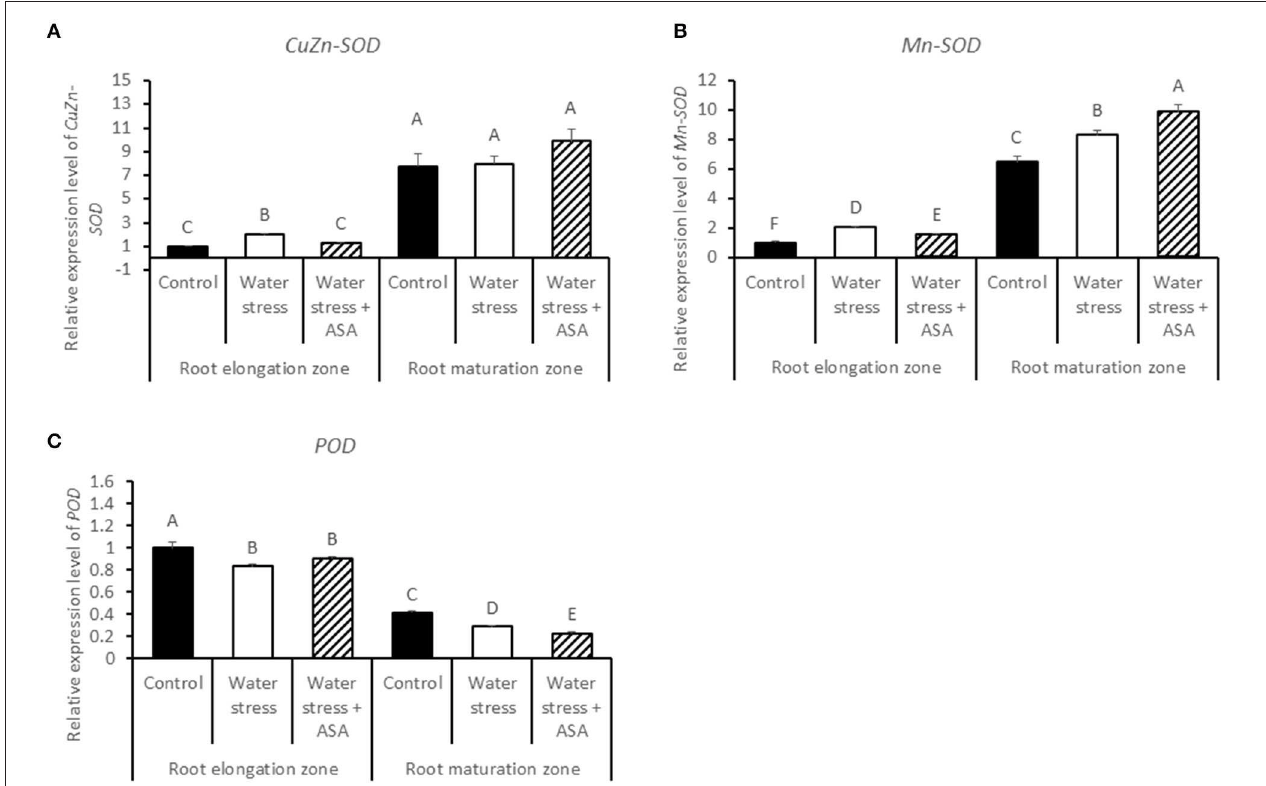
FIGURE 8 | Relative gene expression level of CuZn-SOD (A), Mn-SOD (B), and POD (C) in tall fescue roots exposed to non-stress control, water stress, and water stress with ASA treatment. The data represent mean ± SE ( n = 4 replicated pots of plants and each pot with multiple plants). Columns marked with the same letter are not significantly different at p < 0.05